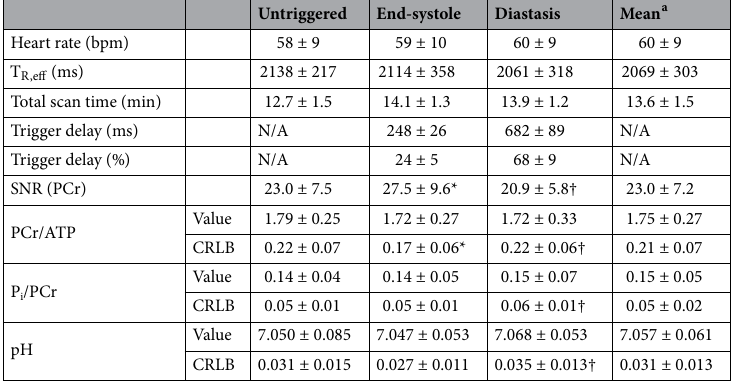
Table 1. Timings and results for untriggered, end-systole and diastasis triggered measurements. Data from the selected voxels of all volunteers are pooled and given as mean ± SD. bpm beats per minute. a Mean of all five acquired scans per volunteer. *Significantly different to untriggered ( P < 0.05 ). † Significant difference between end-systole and diastasis ( P < 0.05